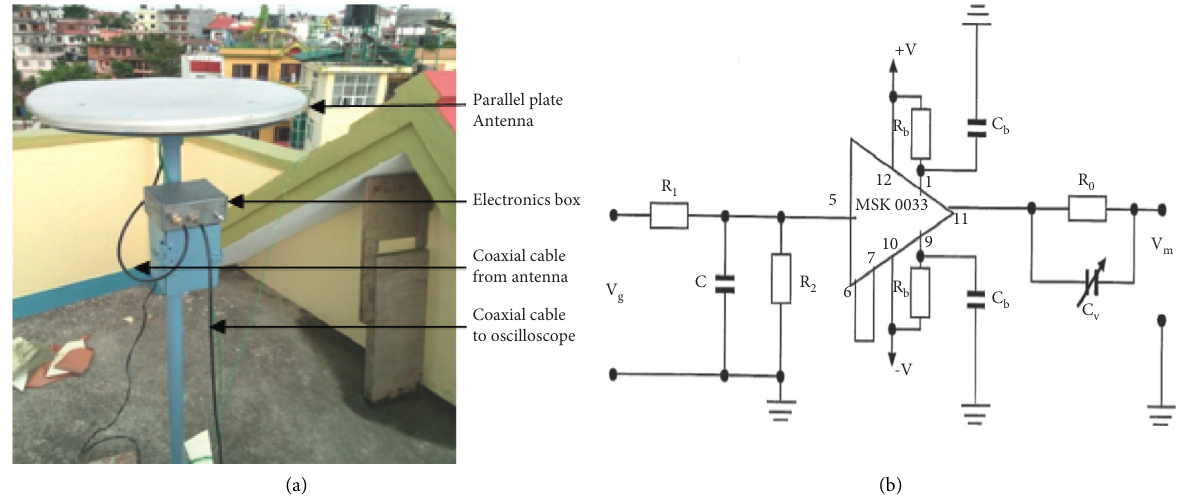
Figure 1: The elevated parallel plate antenna installed in Kathmandu (a) and the electronic circuit pertinent to the buffer amplifier